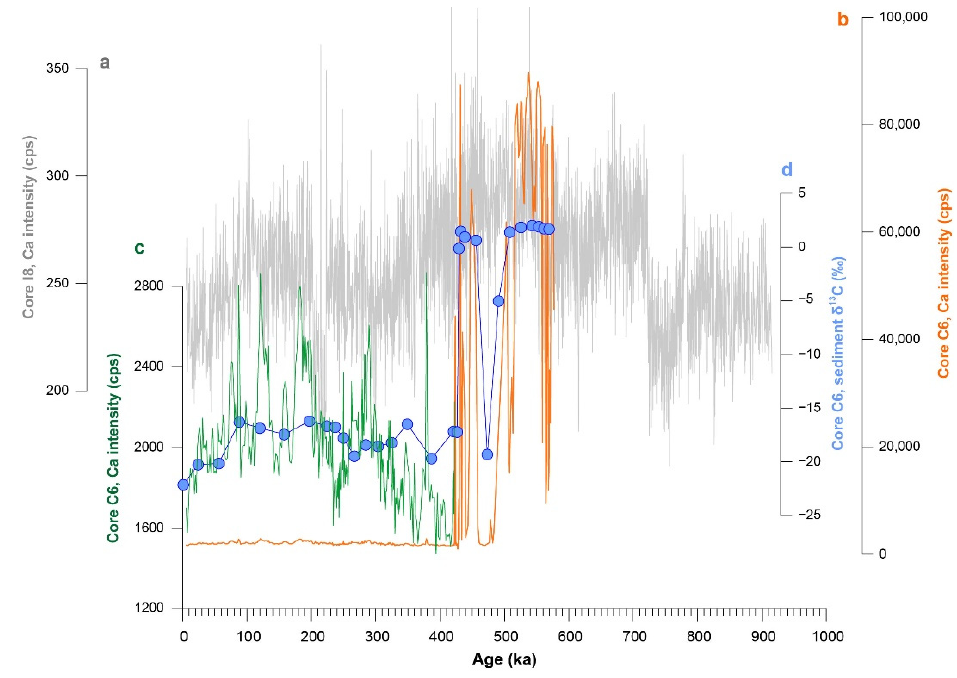
Figure 4. Changes in deep-sea carbon record. ( a ) Ca record of core I8; ( b , c ) Ca record of core C6; ( d ) bulk carbon δ 13 C record of core C6.